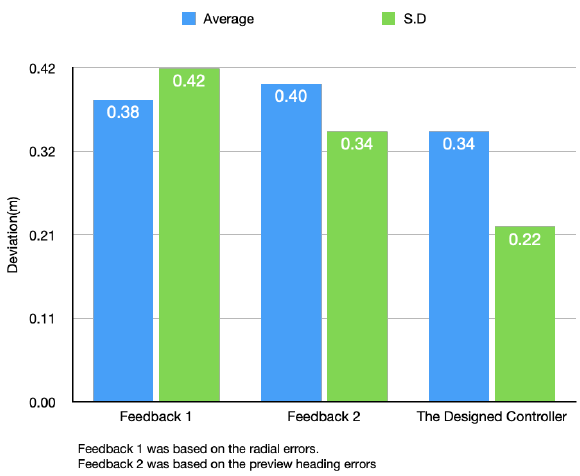
Figure 14. Deviation comparison during the experiment test.